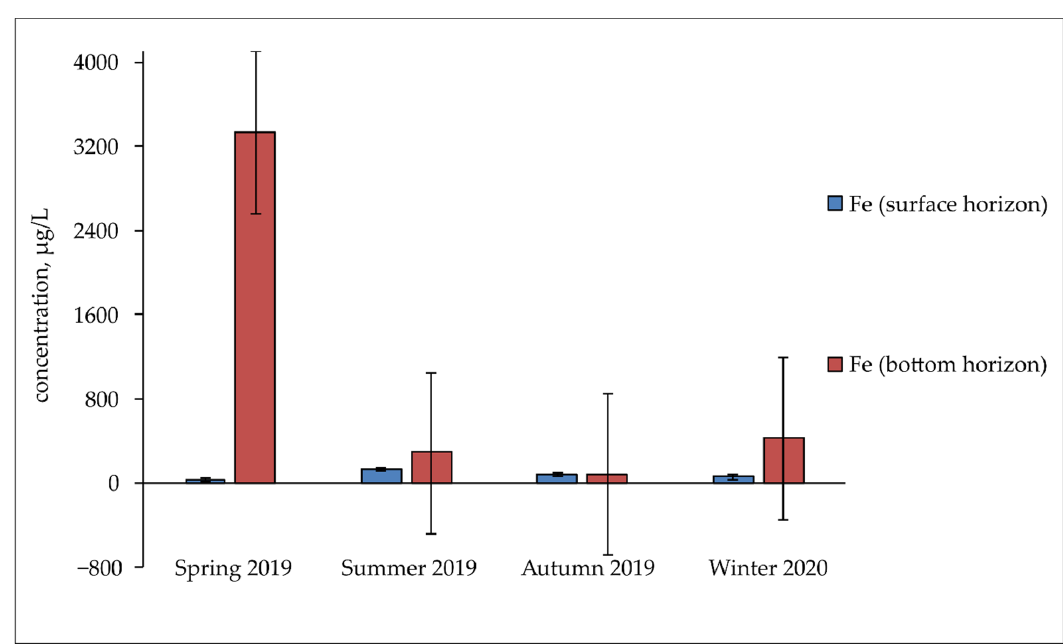
Figure 4. Seasonal and vertical variation of V, Ni, Mn, Cu, Zn contents in Lake Semenovskoe in 2019–2020 .